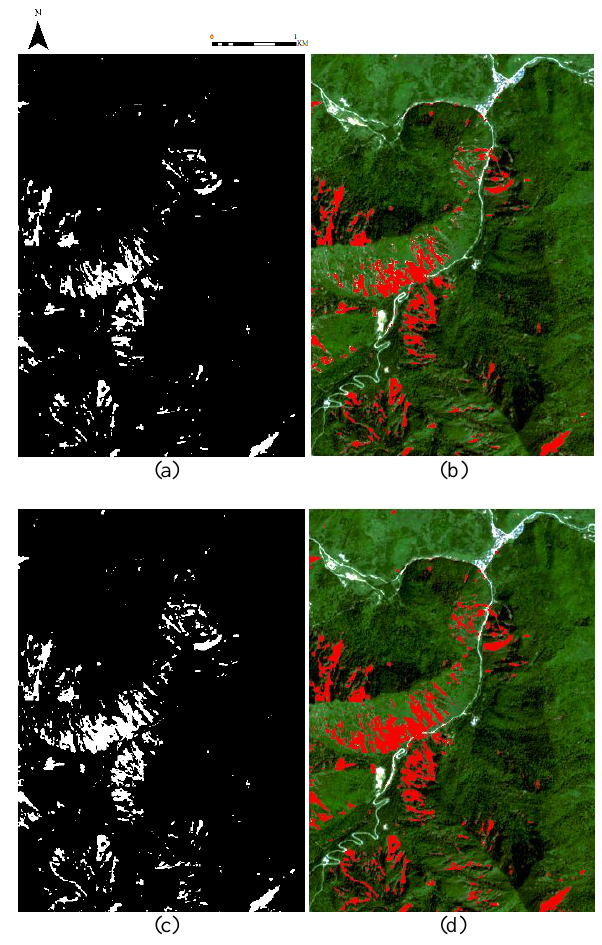
Figure 4. Landslide mapping results of MRF. (a) Binary result of using δ NDVI . (b) Landslides in (a) overlaid on the post-event image. (c) Binary result of using PCA-4. (d) Landslides in (c) overlaid on the post-event image.